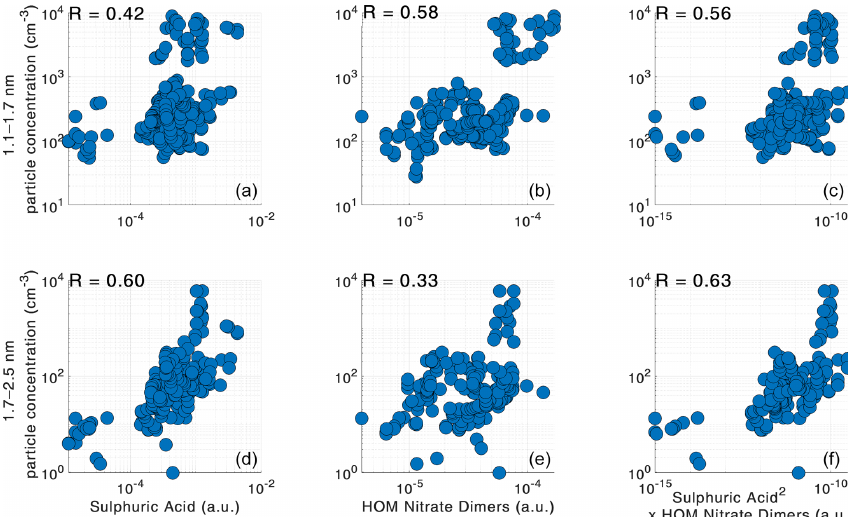
Figure 12. The best logarithmic correlations between particle concentrations measured by PSM and precursor vapors during NPF events occurring between 10 and 14. The correlations of sub-3nm particle concentrations and sulfuric acid are in (a, d) , the correlations of sub-3nm particle concentrations and HOM nitrate dimers are in (b, e) , and the correlations of sub-3nm particle concentrations and the product of sulfuric acid and HOM nitrate dimers are in (c, f)